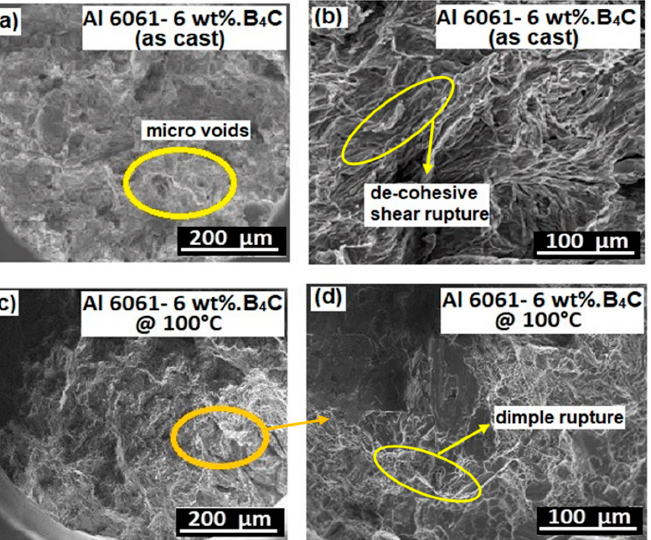
Figure 11. SEM fractographs of as-cast ( a ) Al6061-6 wt.%. B 4 C composite ( b ) at higher magnification. ( c ) Al6061-6 wt.% B 4 C composite peak-aged at 100 °C. ( d ) Different locations at higher magnifica- ( c ) Al6061-6 wt.% B 4 C composite peak-aged at 100 ◦ C. ( d ) Different locations at higher tion.